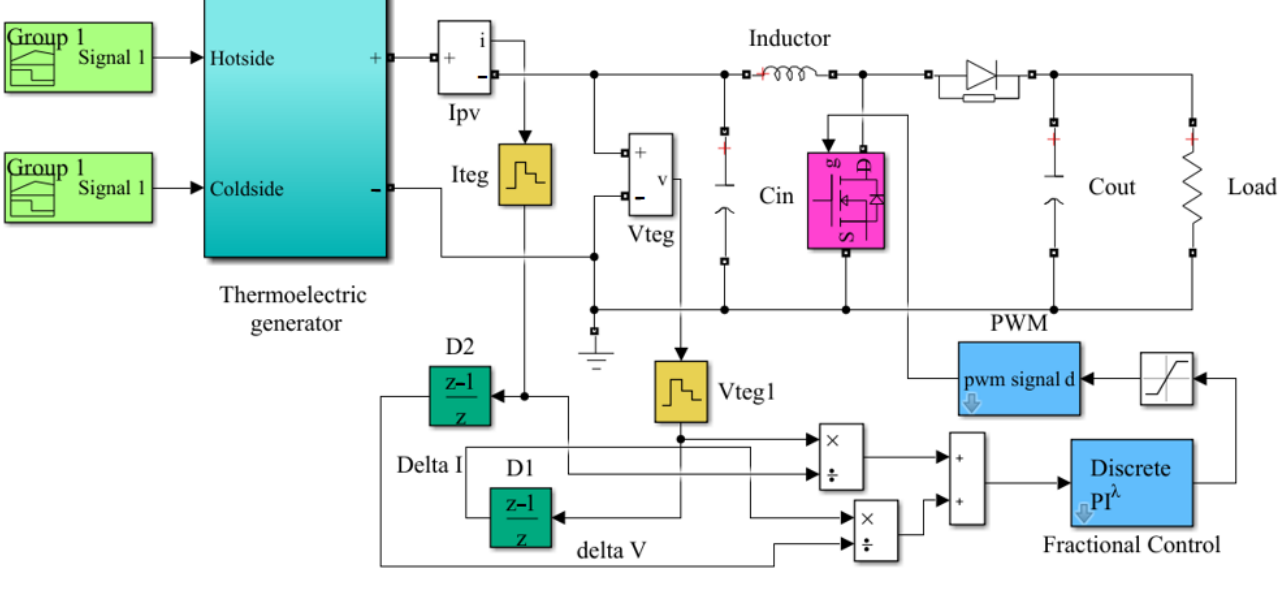
Figure 5. MATLAB model of optimized fractional